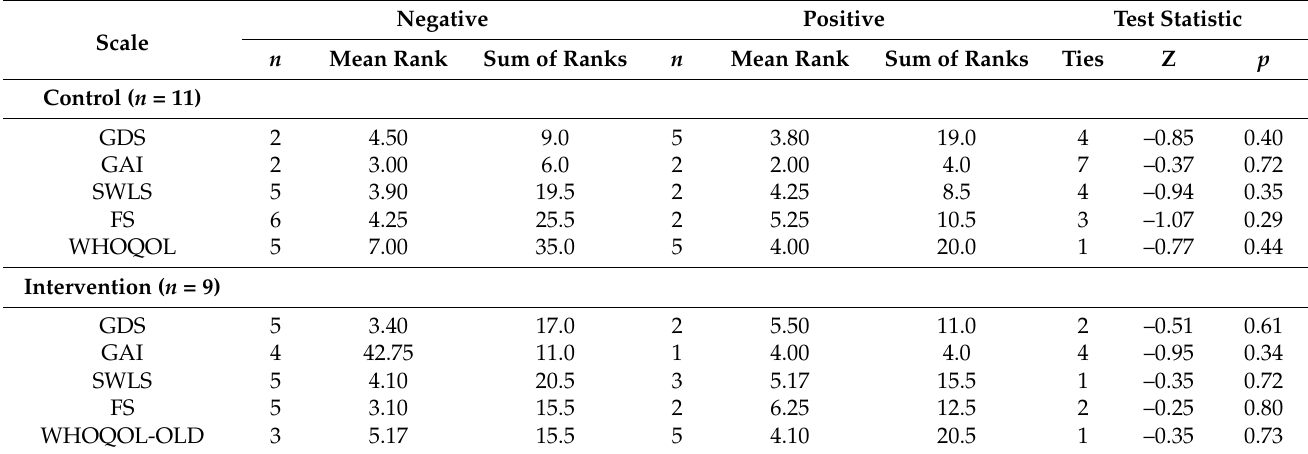
Table 4. Within-group difference for change in outcome scores from baseline to 3 months.